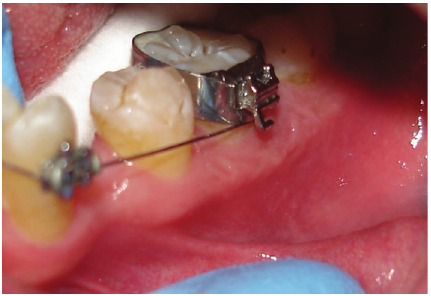
Figure 3: Clinical features at the one-month posttreatment follow- up with no clinical demonstration of residual pathology.